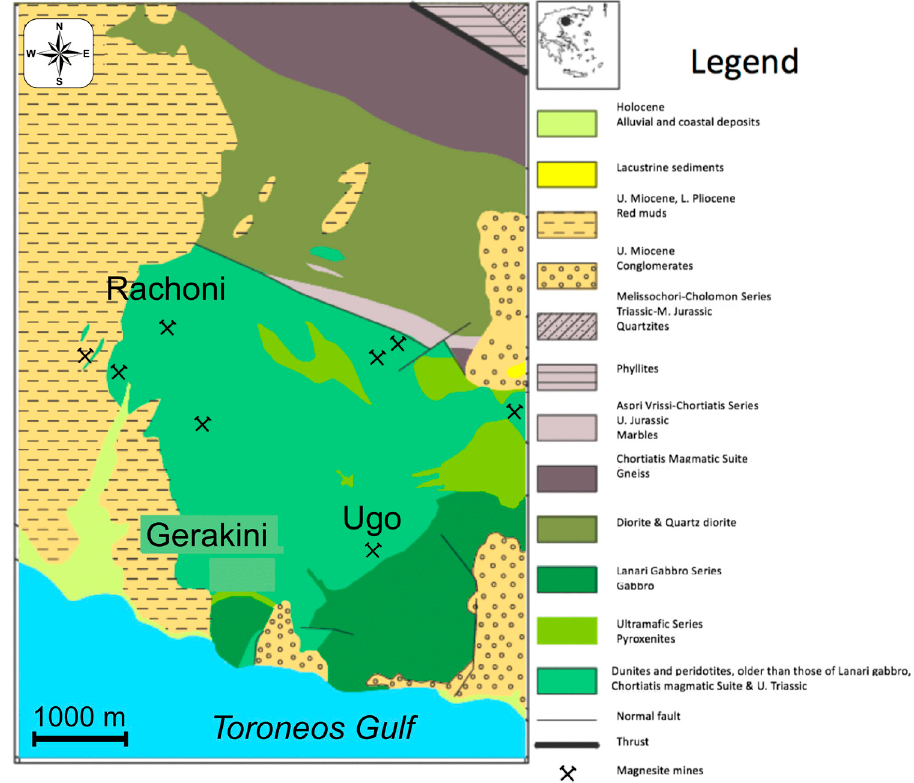
Figure 1. Simplified geological map of the Gerakini mining district [3].